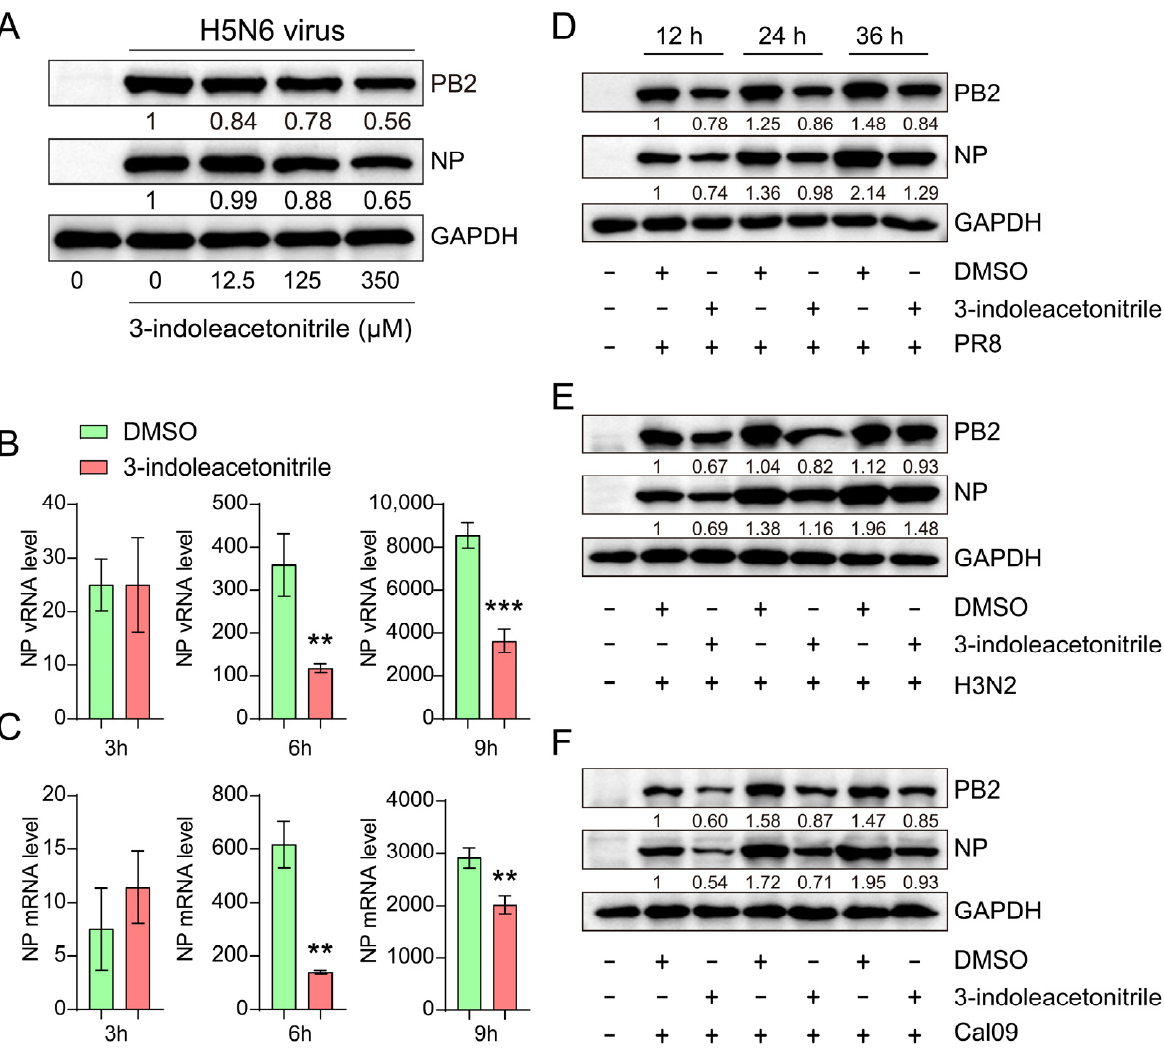
Figure 4. 3-indoleacetonitrile inhibits influenza virus replication with a broad spectrum. ( A ) The protein level of H5N6 NP and PB2 was measured in A549 cells treated with an increased dose of 3-indoleacetonitrile. ( B , C ) The effect of 3- indoleacetonitrile on H5N6 vRNA ( B ) and mRNA ( C ) abundance at 3, 6, and 9 hpi. ( D – F ) Effect of 3-indoleacetonitrile on viral PB2 and NP protein level in A549 cells infected with PR8 ( D ), H3N2 ( E ), or Cal09 ( F ) viruses. ** p < 0.01; *** p < 0.001; calculated from three independent experiments by two-tailed Student’s t